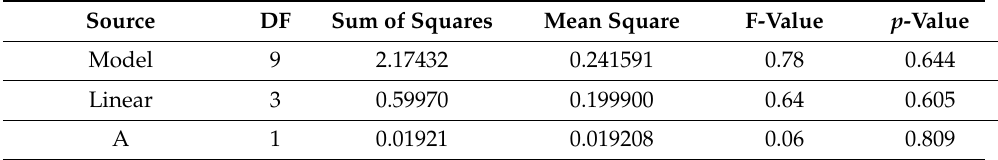
Table 7. ANOVA for electromagnetic interference